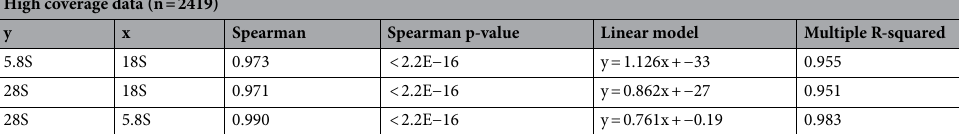
Table 5. Correlations between the three rRNA genes encoded in the 45S repeat unit in the high-coverage 1000 Genomes Project dataset. The Spearman correlation coefficient and linear models that describe the relationships between the 18S, 5.8S, and 28S copy numbers are shown.